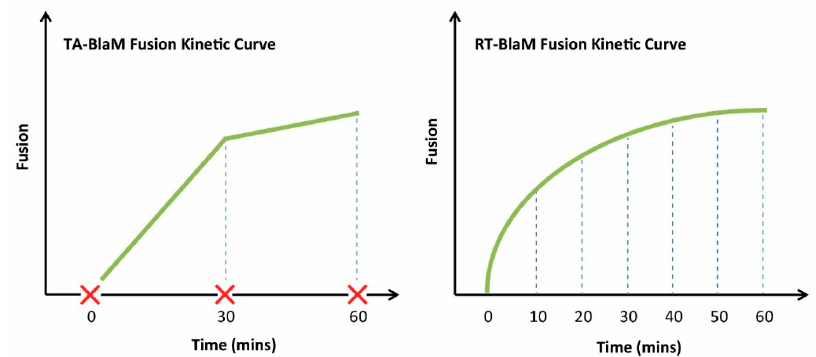
Figure 5. To obtain kinetic measurements of fusion using a TA-BlaM assay ( Left ), fusion must be stopped at various time points using a known fusion inhibitor (red cross). The level of fusion that occurred up to the time of inhibition can then be quantified. In a RT-BlaM assay ( Right ), fusion can be measured in real time in the absence of fusion inhibitors.